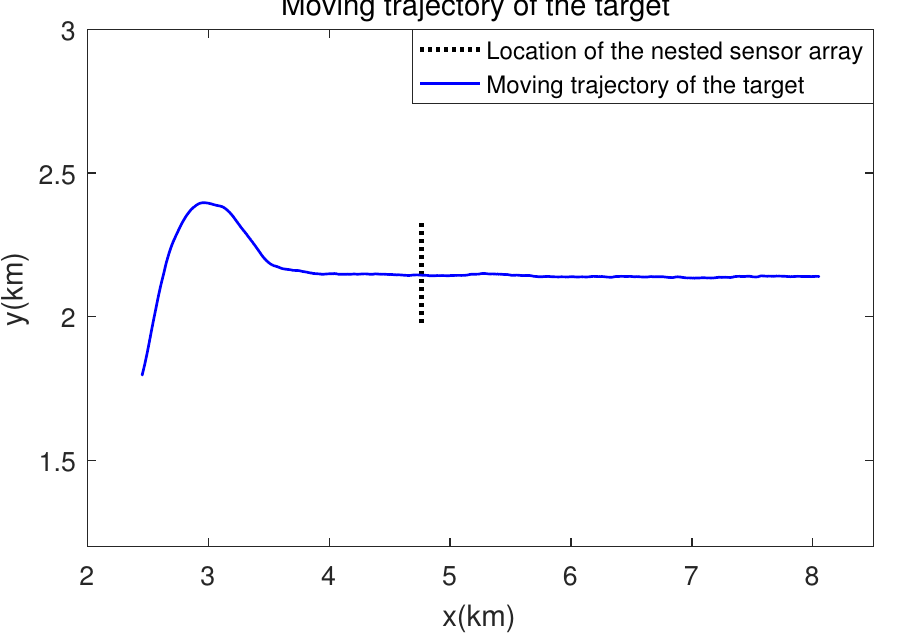
Figure 10. The moving trajectory of the target and the location of the horizontal nested sensor array of the measured data.